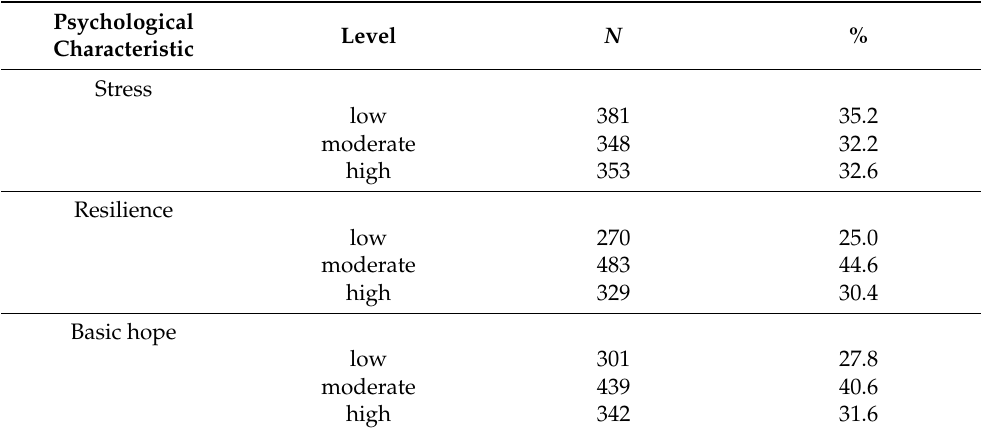
Table 3. The levels of the analysed psychological characteristics according to the norms for the Polish population.